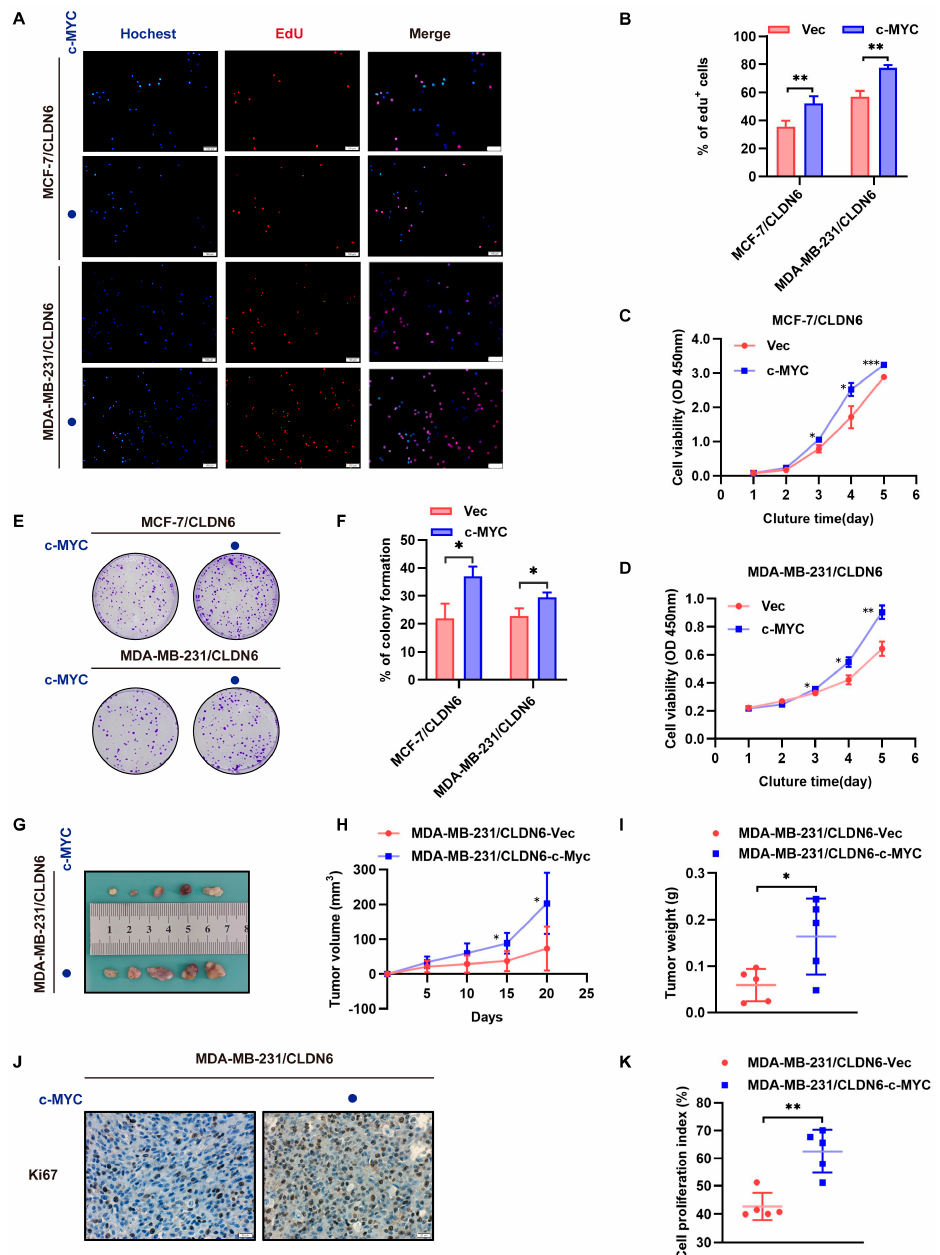
Figure 6. CLDN6 inhibits breast cancer cell proliferation via c–MYC in vitro and in vivo. ( A , B ) Cell proliferation ability was determined by EdU. Scale bar, 100 µ m. CCK8 assay ( C , D ) to assess the effect of c–MYC on cell viability and clone formation assay ( E , F ) to assess the effect of c–MYC on cell proliferation in MCF–7/CLDN6 and MDA–MB–231/CLDN6 cells. ( G ) Subcutaneous xenograft tumor growth in nude mice (5 per group) was measured and compared in tumor volume ( H ) and weight ( I ). ( J ) Representative images of IHC staining of Ki67 of tumor sections. Scale bar, 20 µ m. ( K ) Cell proliferation index was determined by the proportion of nuclear Ki67-positive cells. * p < 0.05, ** p < 0.01, *** p < 0.001.